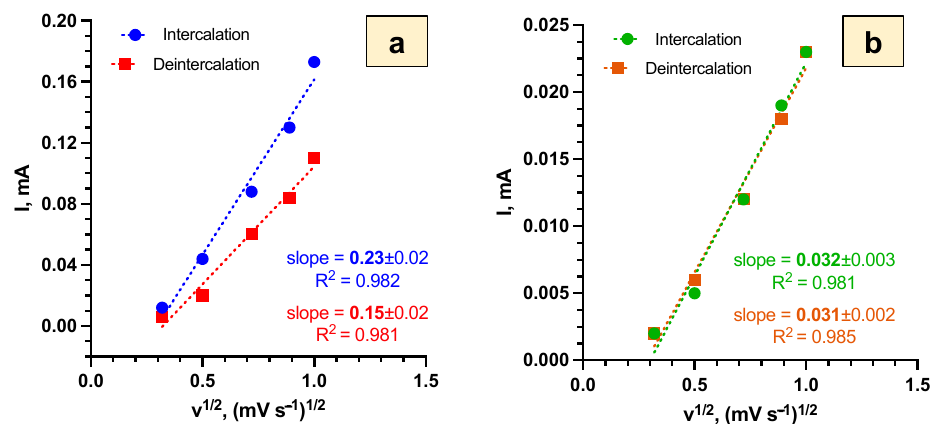
Figure 8. Dependence of v 1/2 vs. I for Bi 2 Se 3 thin films in 5 M LiNO 3 for Li + intercalation/deintercalation with fitted slope values for: ( a )— SEI layer ( − 1.0 V ÷ 1.3 V vs. Ag/AgCl), ( b )— Bi 2 O 3 layer ( − 1.0 V ÷ 0.5 V vs. Ag/AgCl). Table 2. Comparison of Li + intercalation and deintercalation diffusion coefficients (cm 2 s − 1 ) for different anodes and